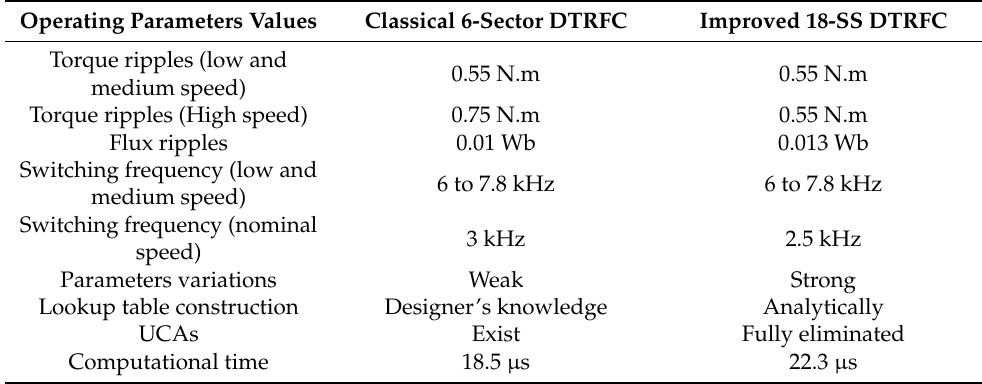
Table 4. Comprehensive comparison of the proposed approach to the conventional